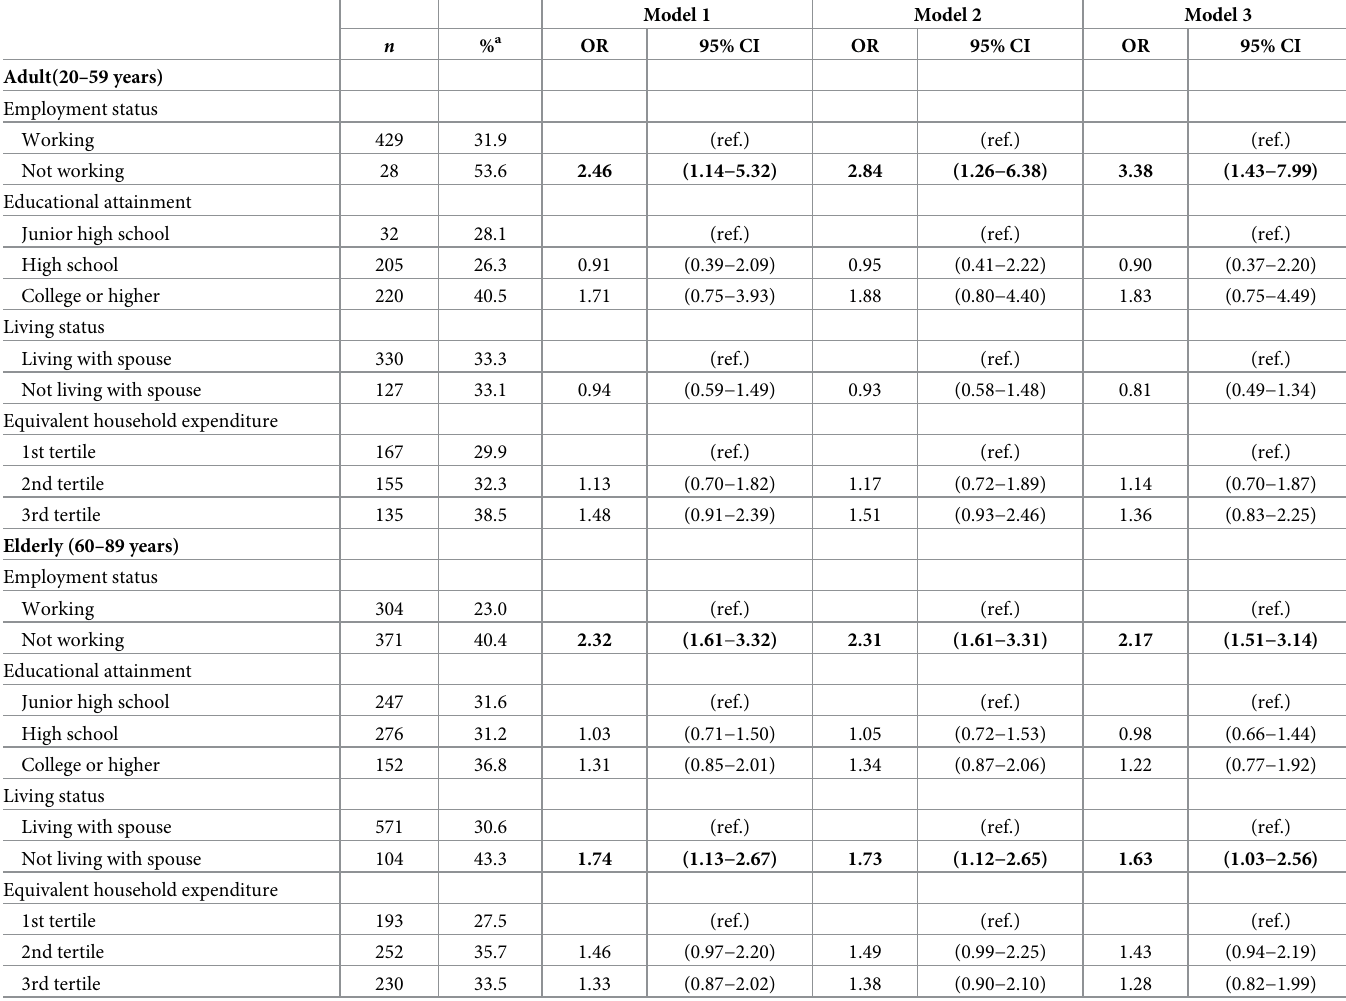
Table 3. Association between socioeconomic status and physical inactivity in men ( n =